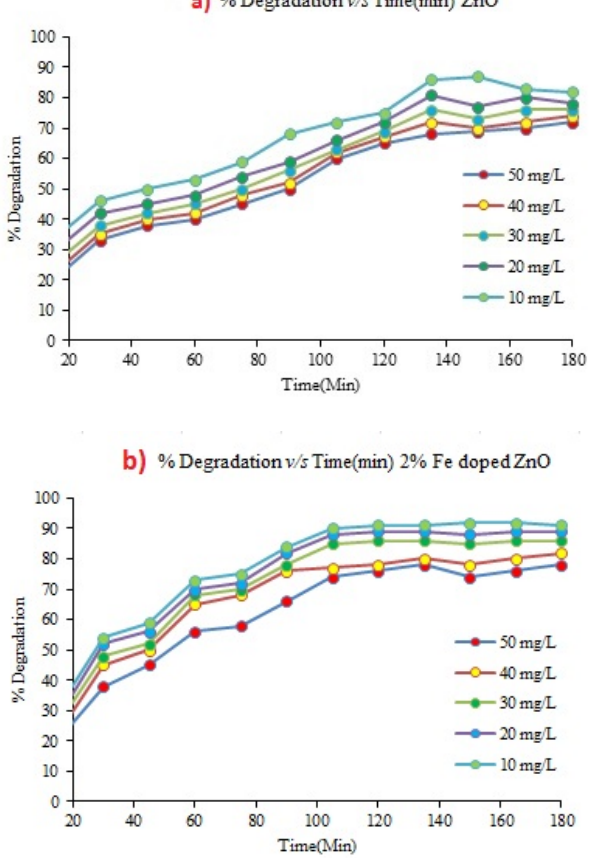
Fig. 7. Effect of initial dye concentration on the photocatalytic degradation (a) MB conditions: pH=2, dye concentration 10, 20, 30, 40, 50 mg/L and (ZnO) catalyst dose 1 g/L for irradiation time 180 min. (b) MB conditions: pH= 2 dye concentration 10, 20, 30, 40, 50 mg/L and (2% Fe-ZnO) catalyst dose 1 g/L for irradiation time 180 min.